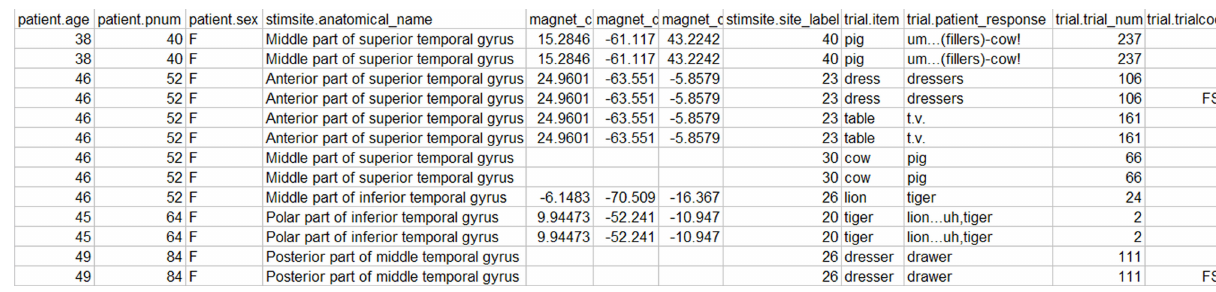
FIGURE 6 | CSV output displayed in Excel.